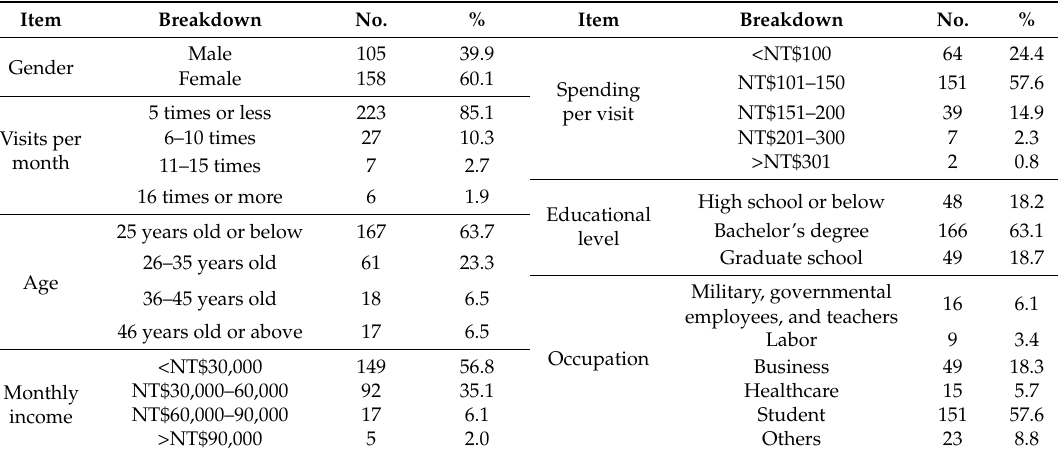
Table 5. Descriptive statistical data for the Kano model